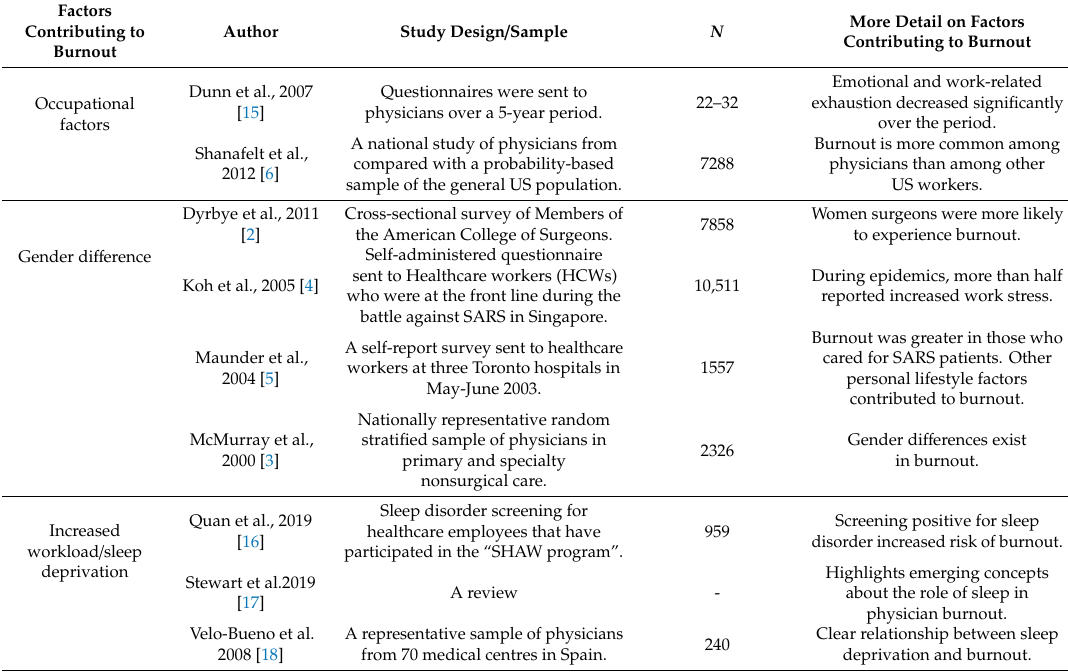
Table 3. Methodological characteristics and the main results for studies prior to COVID-19 on potential factors contributing to